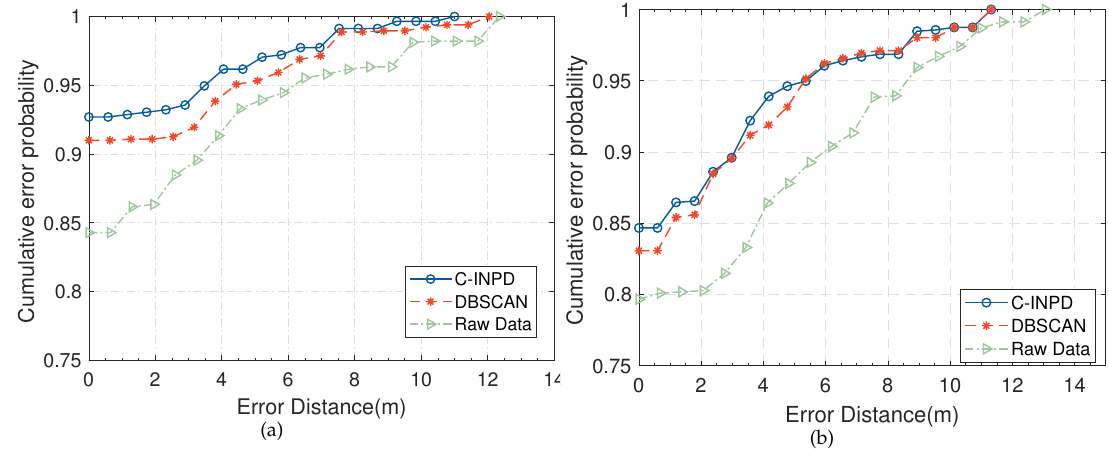
Figure 18. The comparison of positioning performance among C-InP, DBSCAN and raw data-based approach. ( a ) The CDF comparison in the integrated room. ( b ) The CDF comparison in the garage.